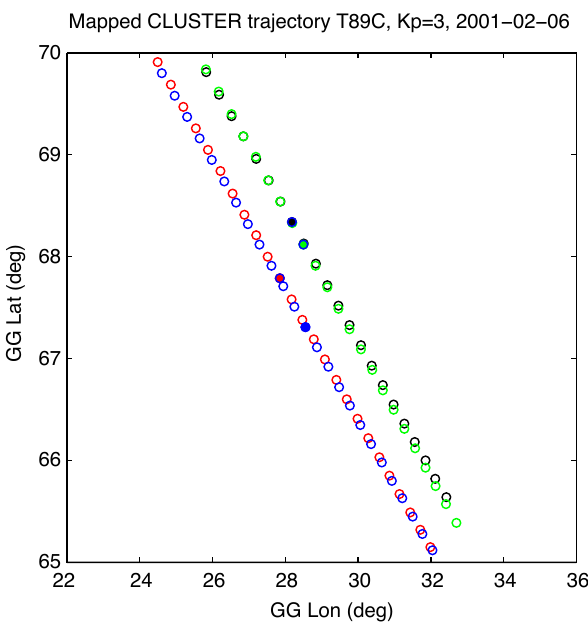
Fig. 1. Ground projection of C1 (black), C2 (red), C3 (green) and C4 (blue) trajectory on 6 February 2001 23:14–23:40 UT, with 1-min resolution. Solid dots show instantaneous position at 23:28 UT.